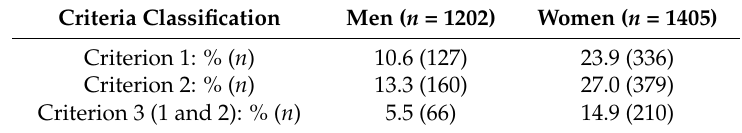
Table 3. Combined classification for the total water intake (TWI) following established